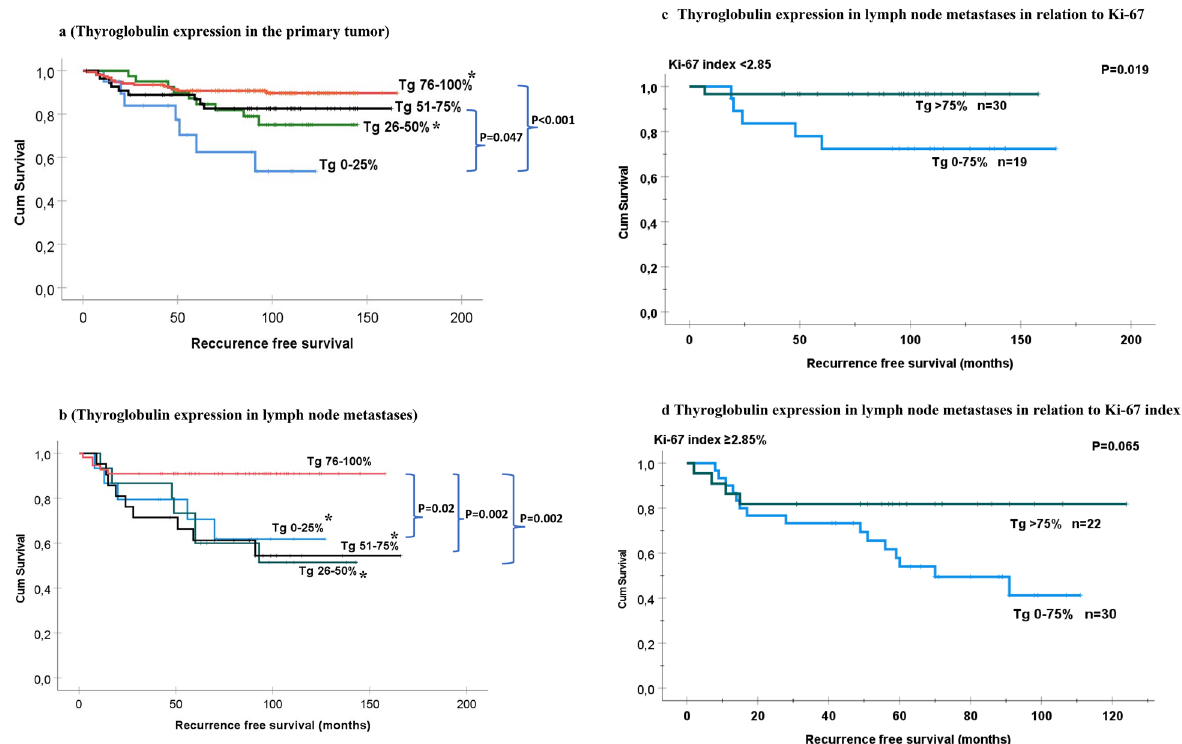
Figure 4. Recurrence-free survival (RFS) in patients with papillary thyroid cancer was analyzed as Kaplan– Meier curves with multiple comparison corrections comparing tumor recurrence in relation to thyroglobulin expression in primary PTC ( a ) and paired lymph node metastases ( b ). In panels ( c ) and ( d ), RFS is estimated in relation to thyroglobulin expression and Ki-67 index in PTC lymph node